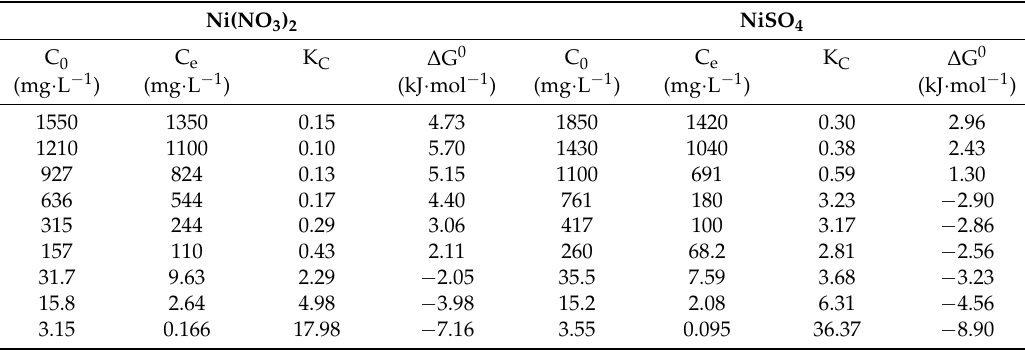
Table 1. Equilibrium constant K C and Gibbs free energy change ∆ G 0 at T = 298 K of the adsorption of nickel on chitosan in dependence on the initial concentration and the salt anion in solution. The contact time was 24